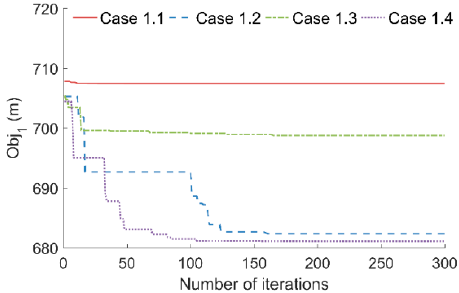
Figure 11. Objective function variations with the number of iterations (Case 1).